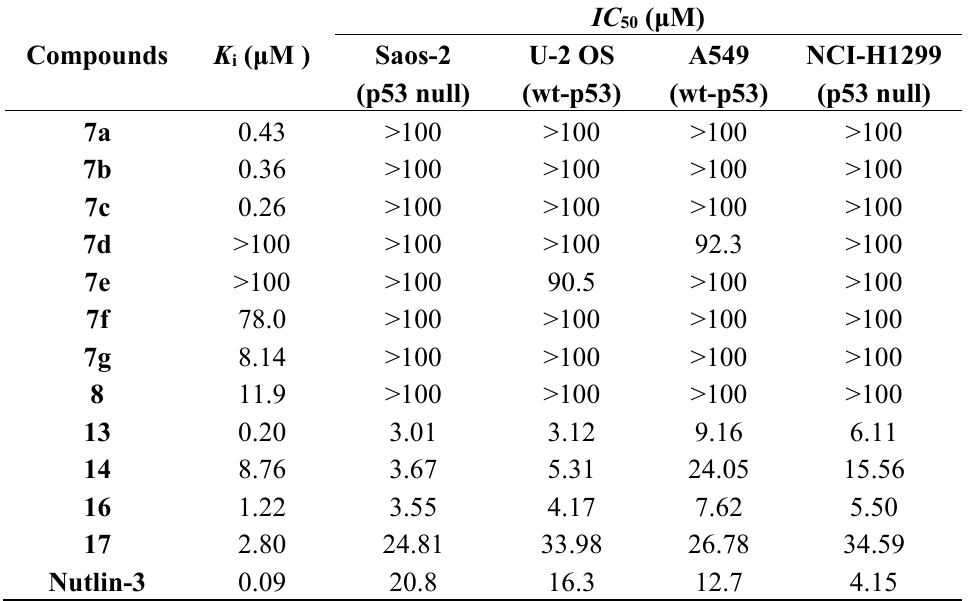
Table 1. In vitro activity of the designed compounds.